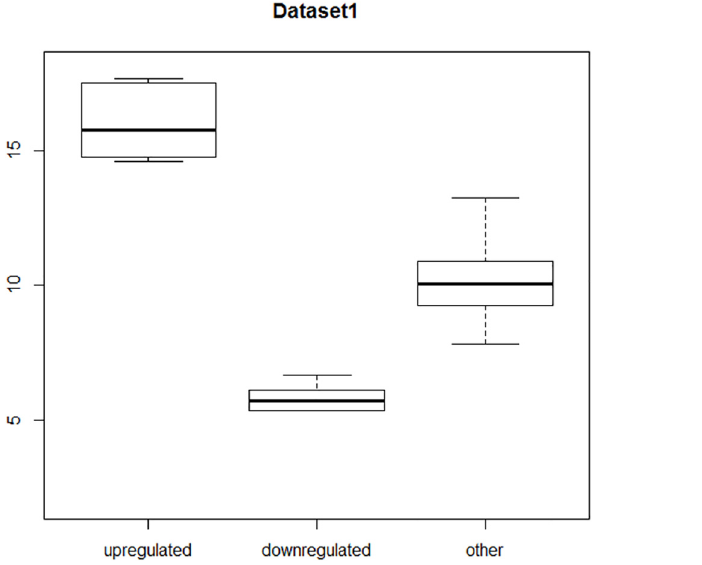
Fig 4. Distribution of values in Dataset1.